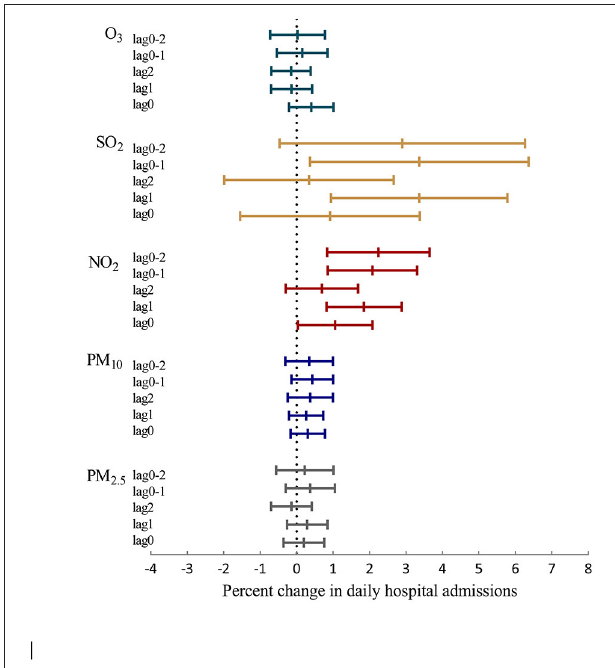
FIGURE 3 | Percentage changes and 95% CIs in daily hospital admissions for stroke per 10 µ g/m 3 increase in PM 2.5 , PM 10 , NO 2 , SO 2 , and O 3 concentrations at different lag days.